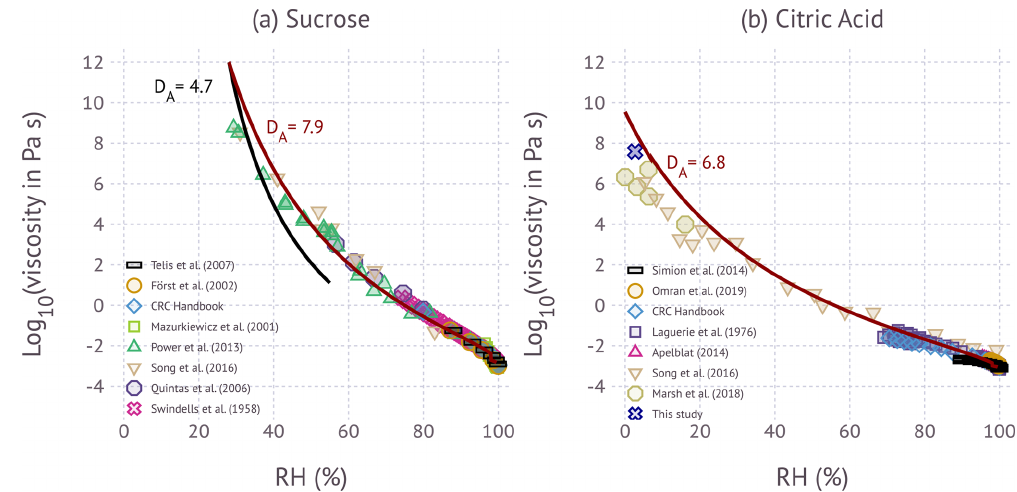
Figure 3. Influence of RH on viscosity for the (a) sucrose and (b) citric acid at room temperature. Symbols correspond to experimental data from different investigators. The colored lines correspond to the model prediction from Eq. (4) using the fragility curves shown in Fig. 2.